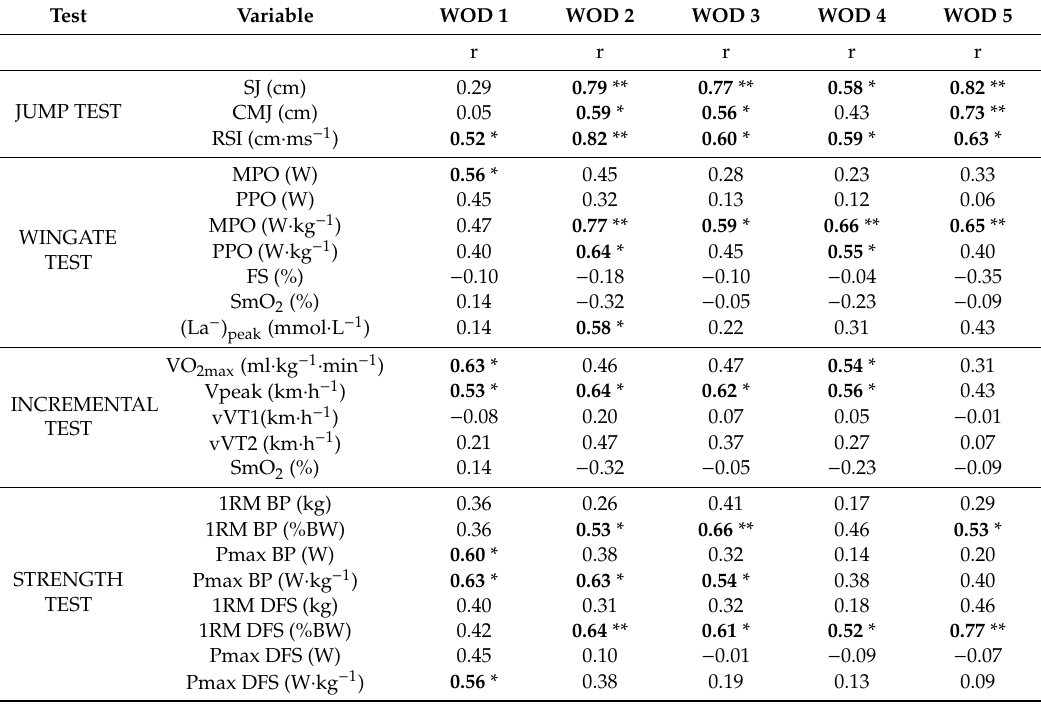
Table 3. Relationship between the di ff erent physiological variables and the repetitions performed on each workout of the